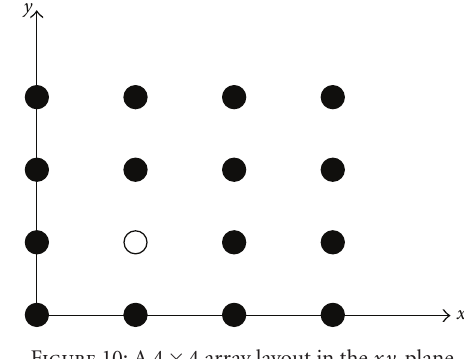
Figure 10: A 4 × 4 array layout in the xy -plane.